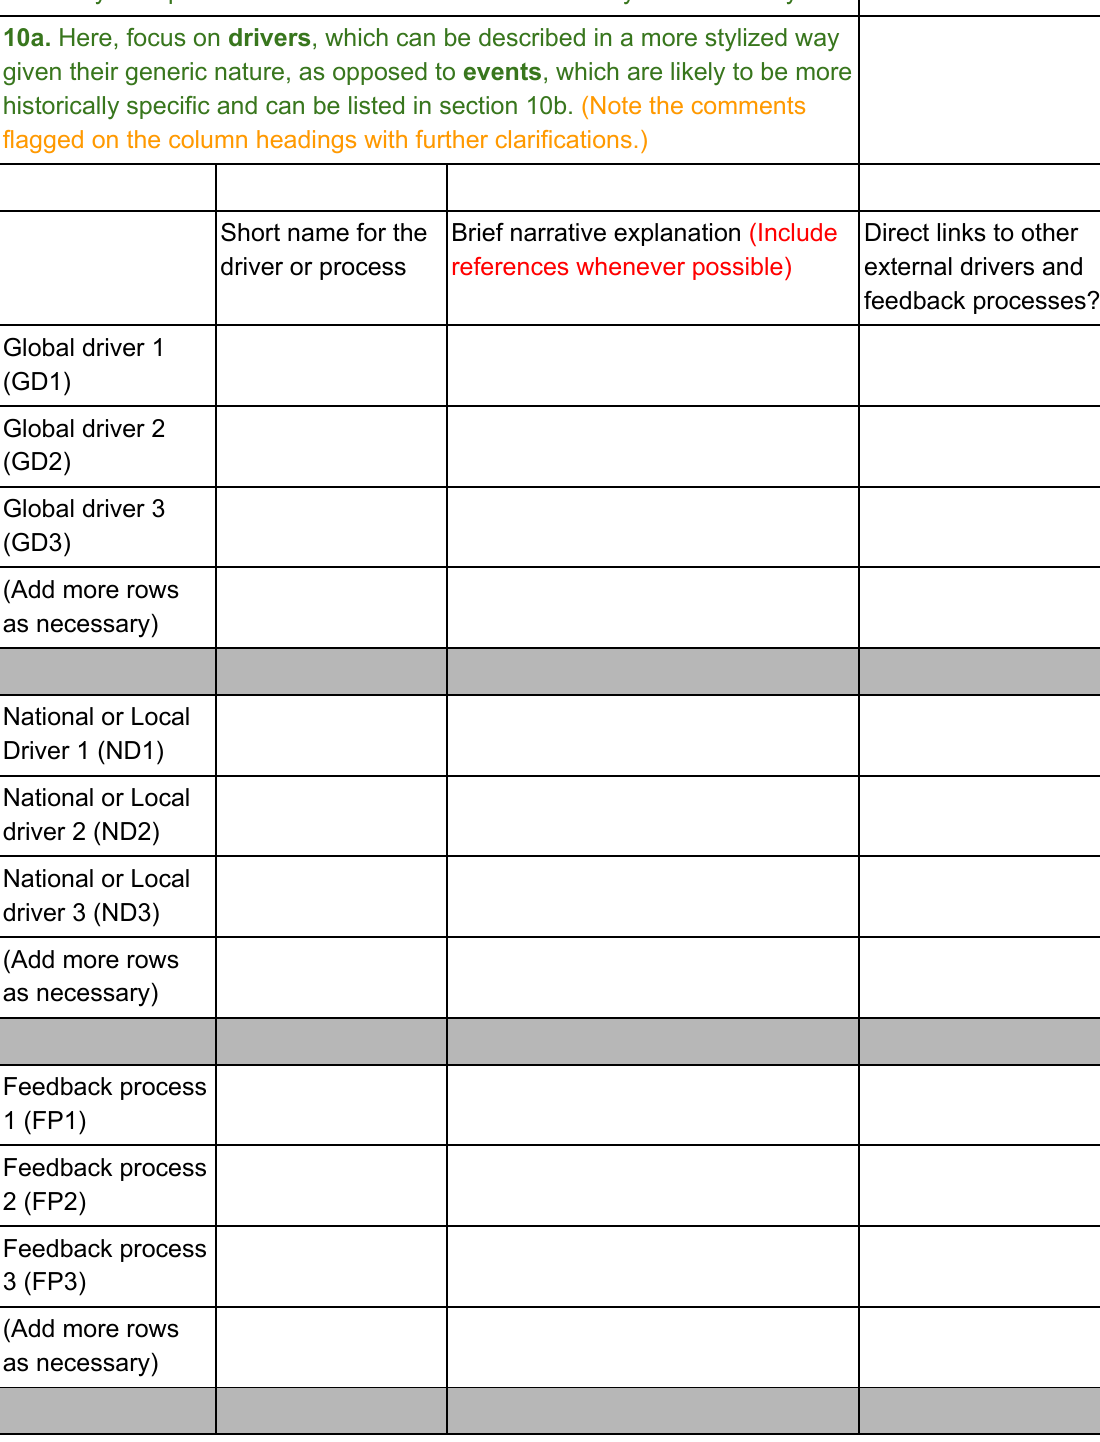
TABLE B How do you explain the above listed trends observed in your case study? 10a. Here, focus on drivers , which can be described in a more stylized way ​​ ​ ​​ given their generic nature, as opposed to events , which are likely to be more ​ ​​ historically specific and can be listed in section 10b. (Note the comments ​ flagged on the column headings with further